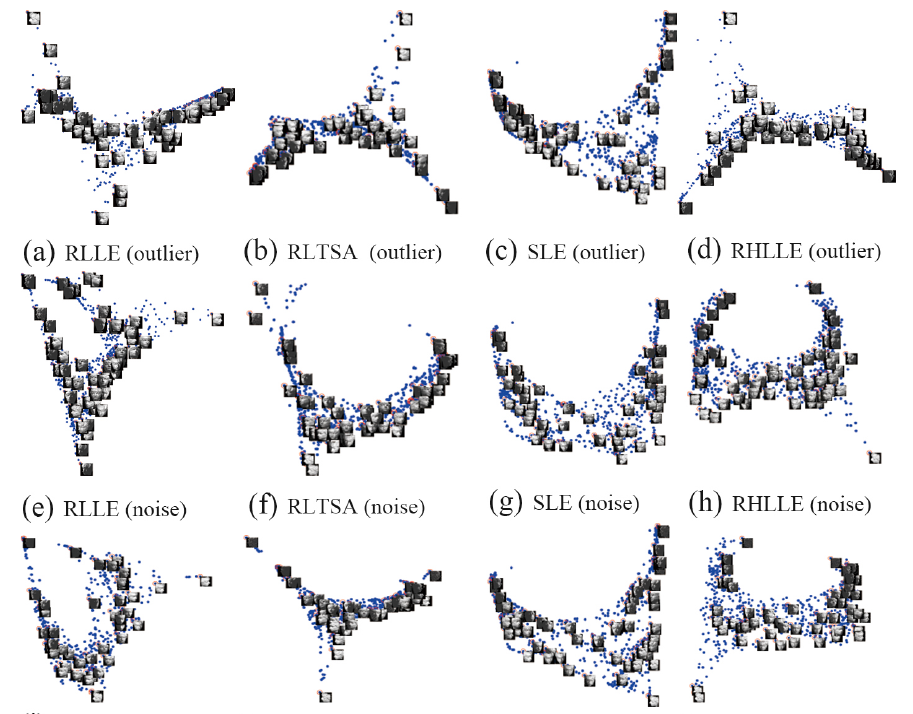
Figure 10. 2-D embedding results of RLLE, RLTSA, SLE and RHLLE on the ISOFACE image set with outliers, noise and both outliers and noise